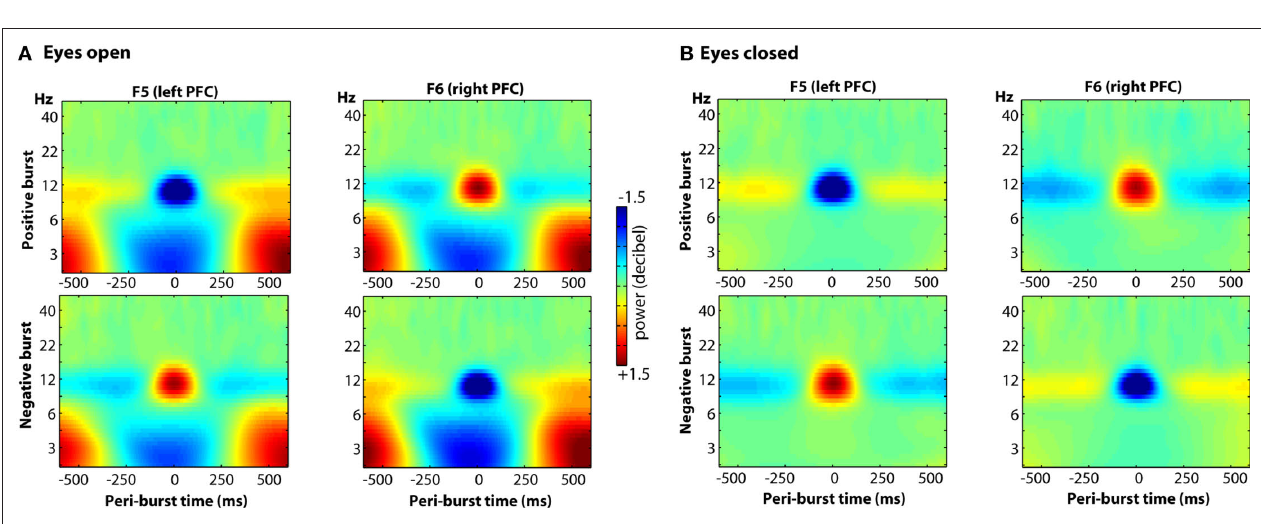
opposite direction. These effects are highly consistent across both eyes-open (A) and eyes-closed (B) conditions, but a relative theta-band suppression accompanying both positive and negative bursts is seen only in the eyes-open (A)